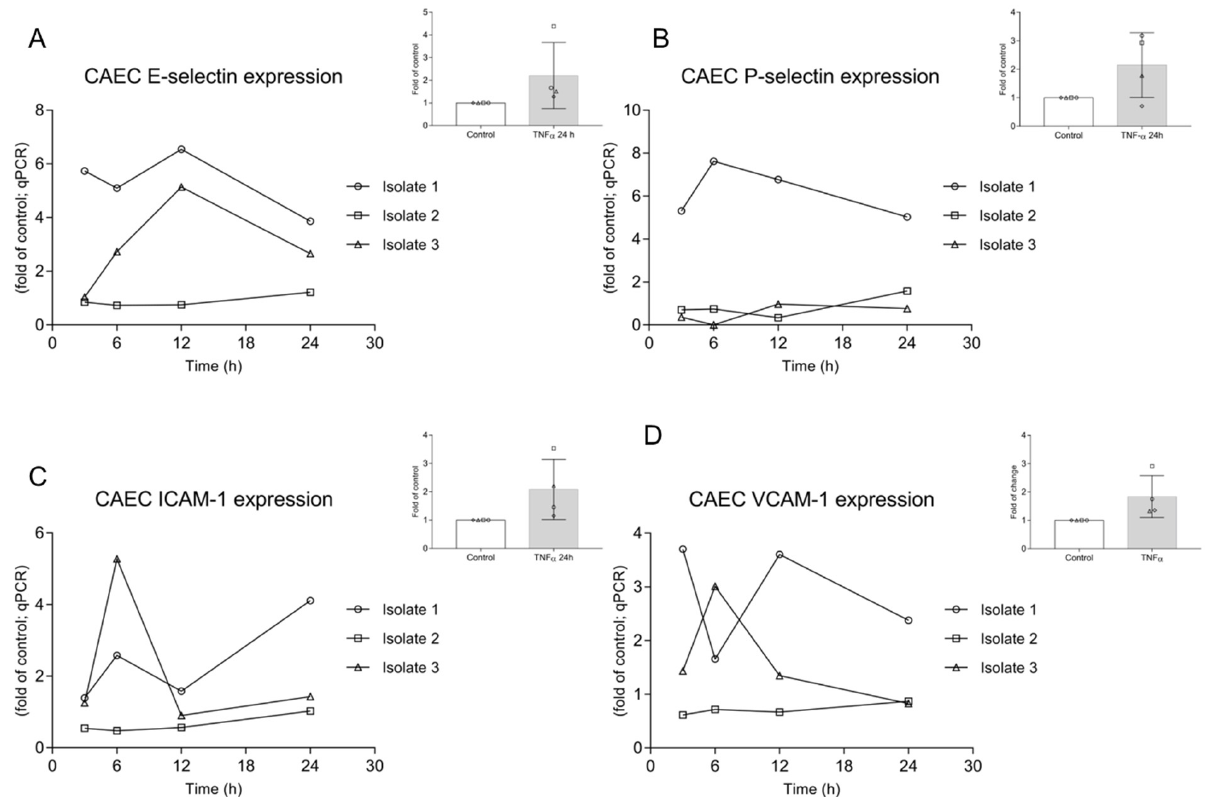
Figure 4. Adhesion molecule gene transcription in A. vasorum antigen ( Av Ag)-stimulated canine endothelial cells. CAEC were stimulated with soluble A. vasorum L3 antigen ( Av Ag; 1 ng/mL) and after 3, 6, 12 and 24 h of incubation total RNA was isolated, reverse transcribed and assayed for E-selectin ( A ), P-selectin ( B ), ICAM-1 ( C ) and VCAM-1 ( D ) gene transcription via qPCR. Data are expressed as n -fold of controls (non-stimulated CAEC). TNF- α stimulation was used as positive control.